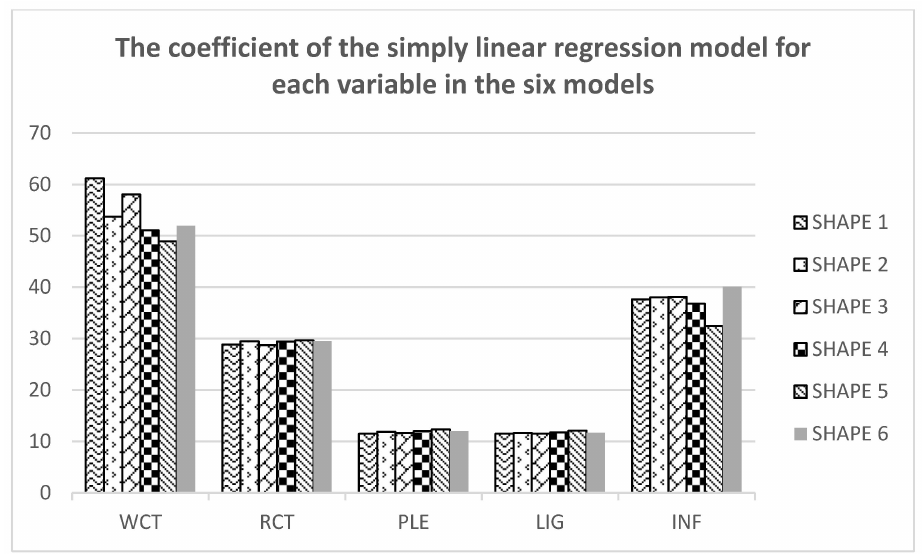
Figure 19. Coefficient plot of variables for 6 Shapes.